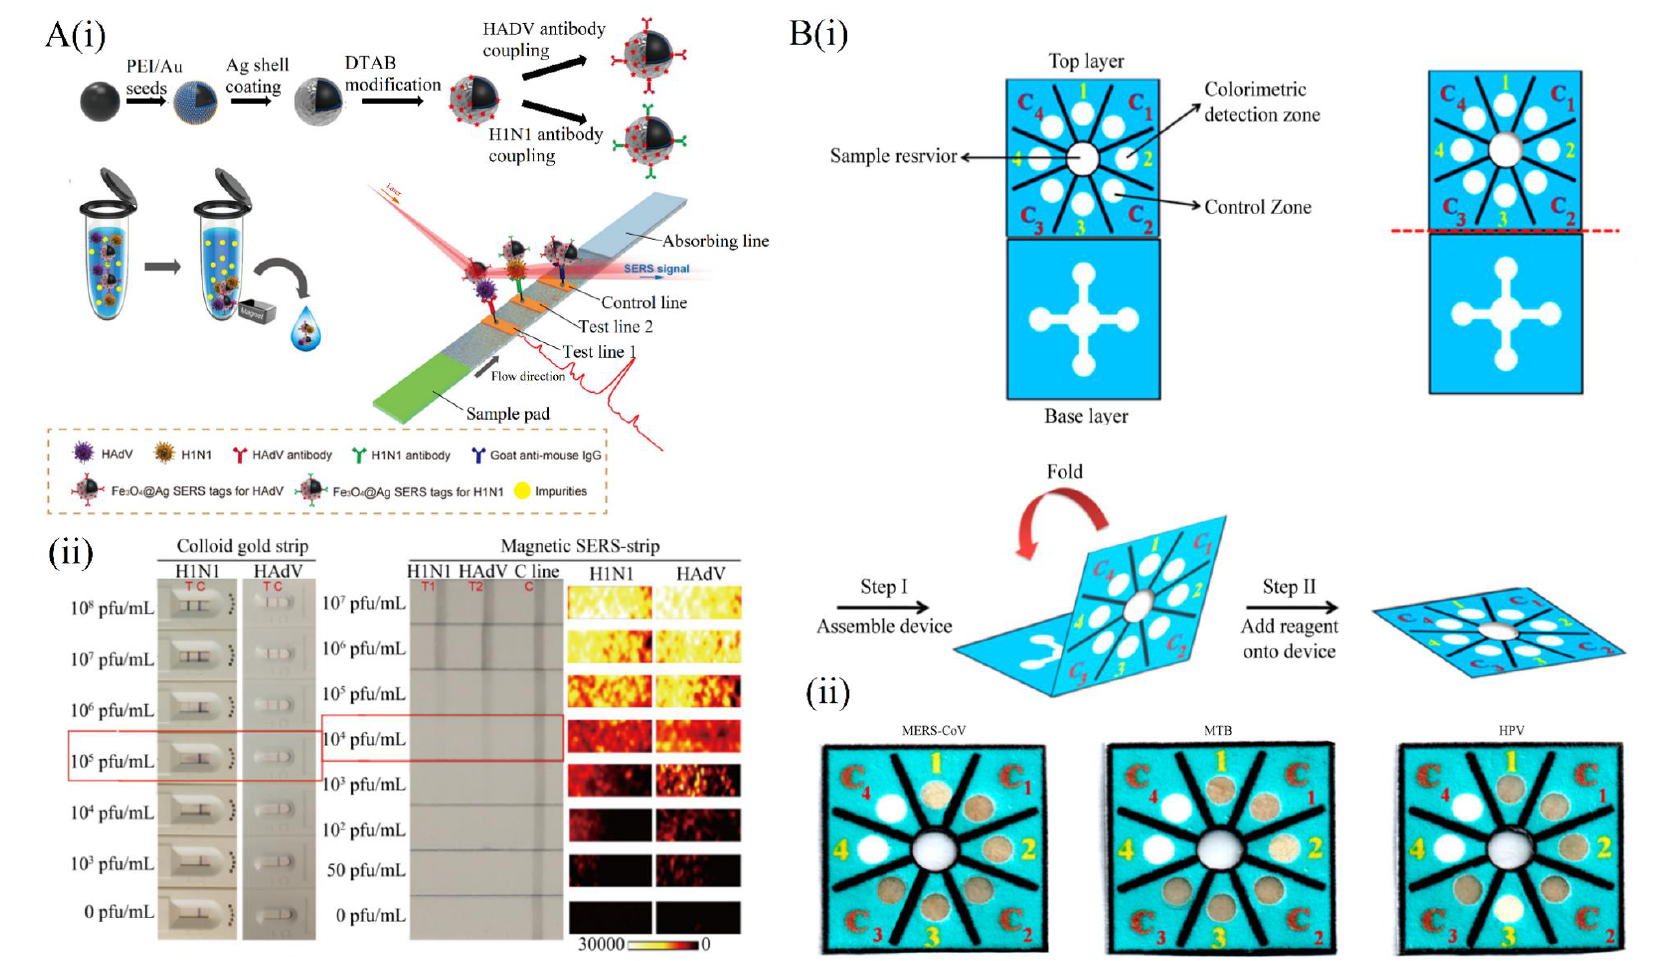
Figure 2. Paper-based strip for respiratory virus detection. ( A ) ( i ) Schematic of the Magnetic SERS Strip in detection of H1N1 and HAdV; ( ii ) Comparison of magnetic SERS strips and commercially gold strips for H1N1 and HAdV detection (reproduced with permission [47]. Copyright 2019, American Chemical Society). ( B ) ( i ) Schematic of Multiplex Paper-Based colorimetric device; ( ii ) selectivity of three virus (i.e., MERS-CoV, MTB, and HPV) detection via multiplex colorimetric paper device (reproduced with permission [49]. Copyright 2017, American Chemical Society).